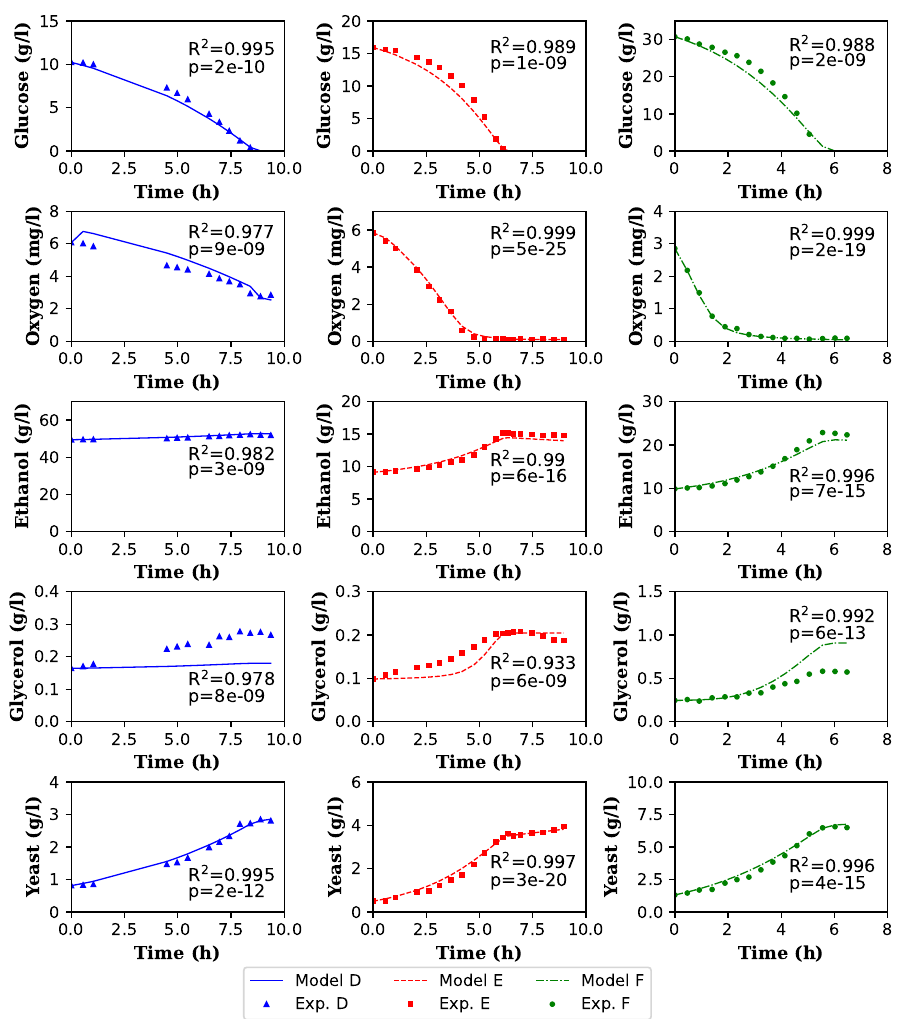
Figure 6. Yeast activity simulation under aerobic conditions. Comparison between model output and experimental